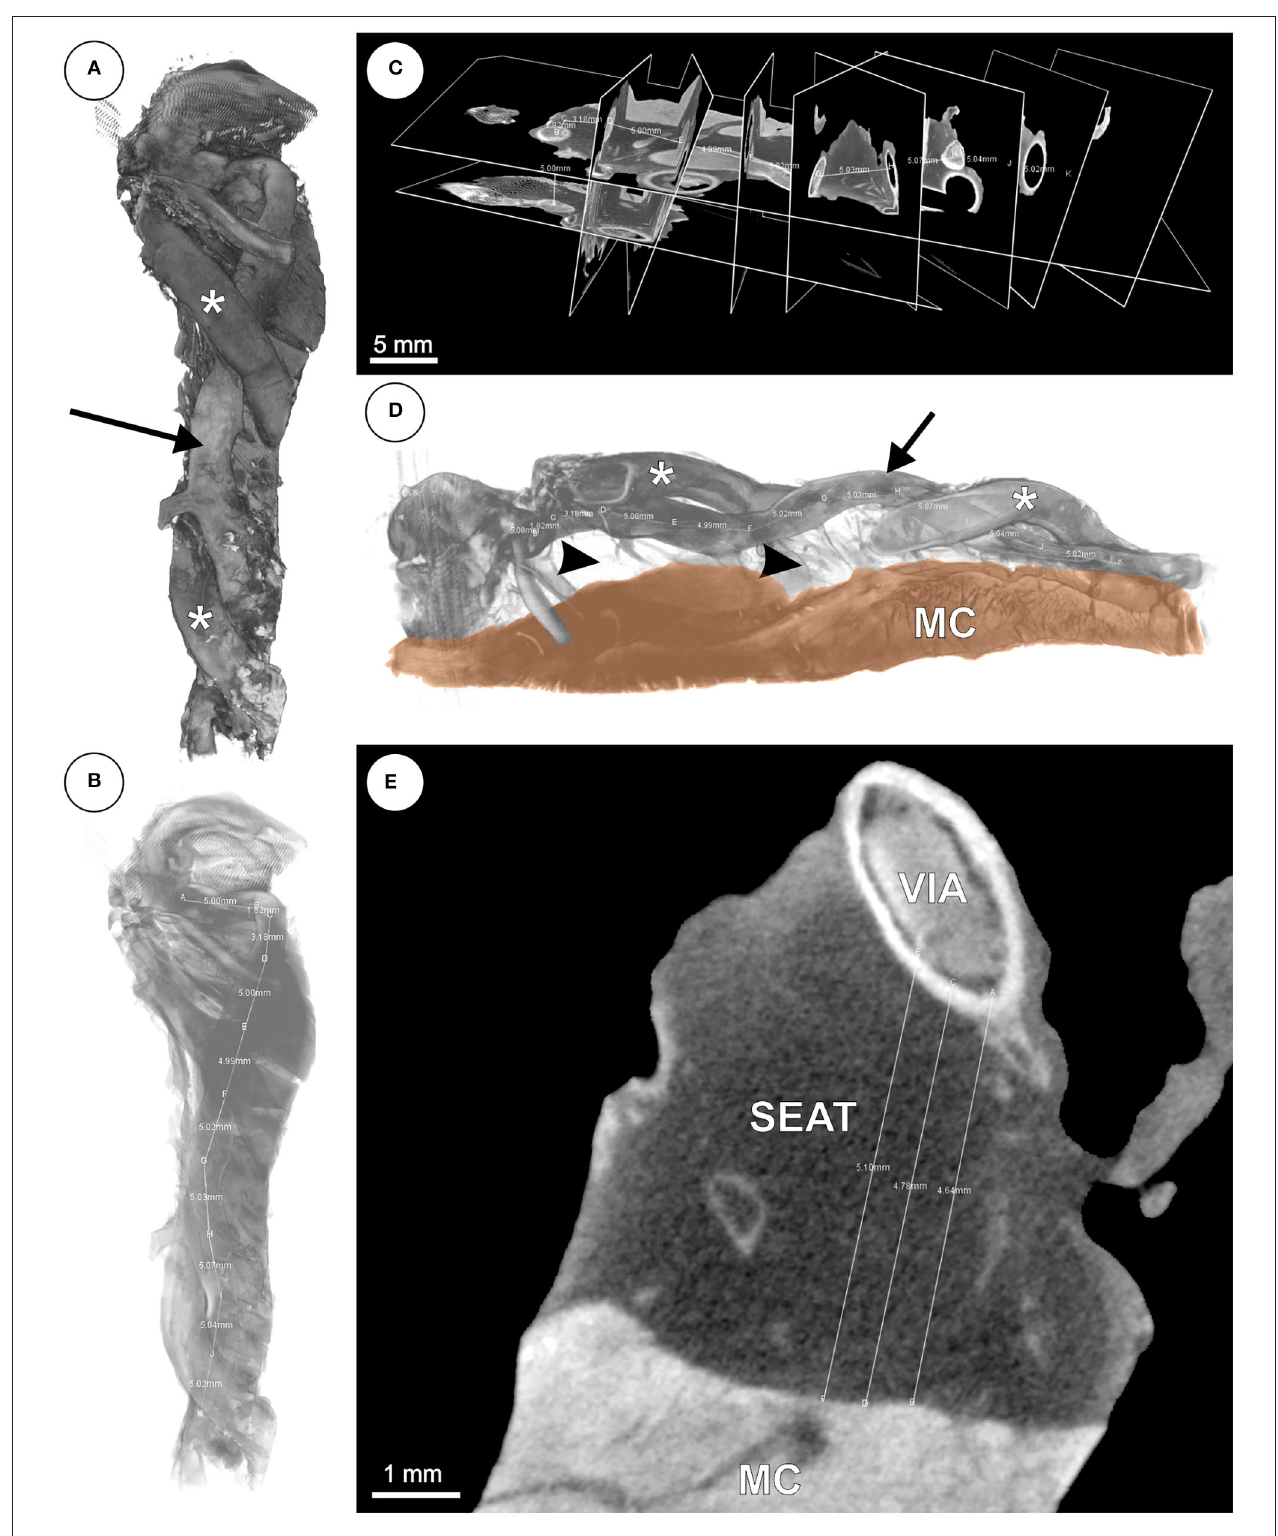
FIGURE 3 | (A–E) mCT based 3D reconstruction of the anterior interventricular vein (VIA). (A) Volume rendering of the VIA (arrow) with adjacent branches of the left anterior descending artery (LAD; asterisks). (B) Volume from panel (A) with decreased opacity and distance measurement. (C) Orthogonal slices of the VIA for distance measurements every 5mm. (D) Volume rendering of the VIA (arrow) with branches of the LAD (asterisks), underlying adipose tissue (arrow heads) and ventricular myocardium (MC). (E) Virtual slice with subvenous epicardial adipose tissue (SEAT) and distance measurements between VIA and MC.